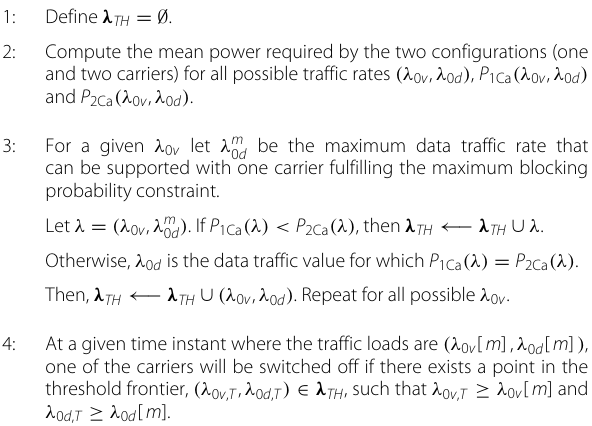
Table 3 Computation of the threshold frontier for switching on/off one carrier assuming with two